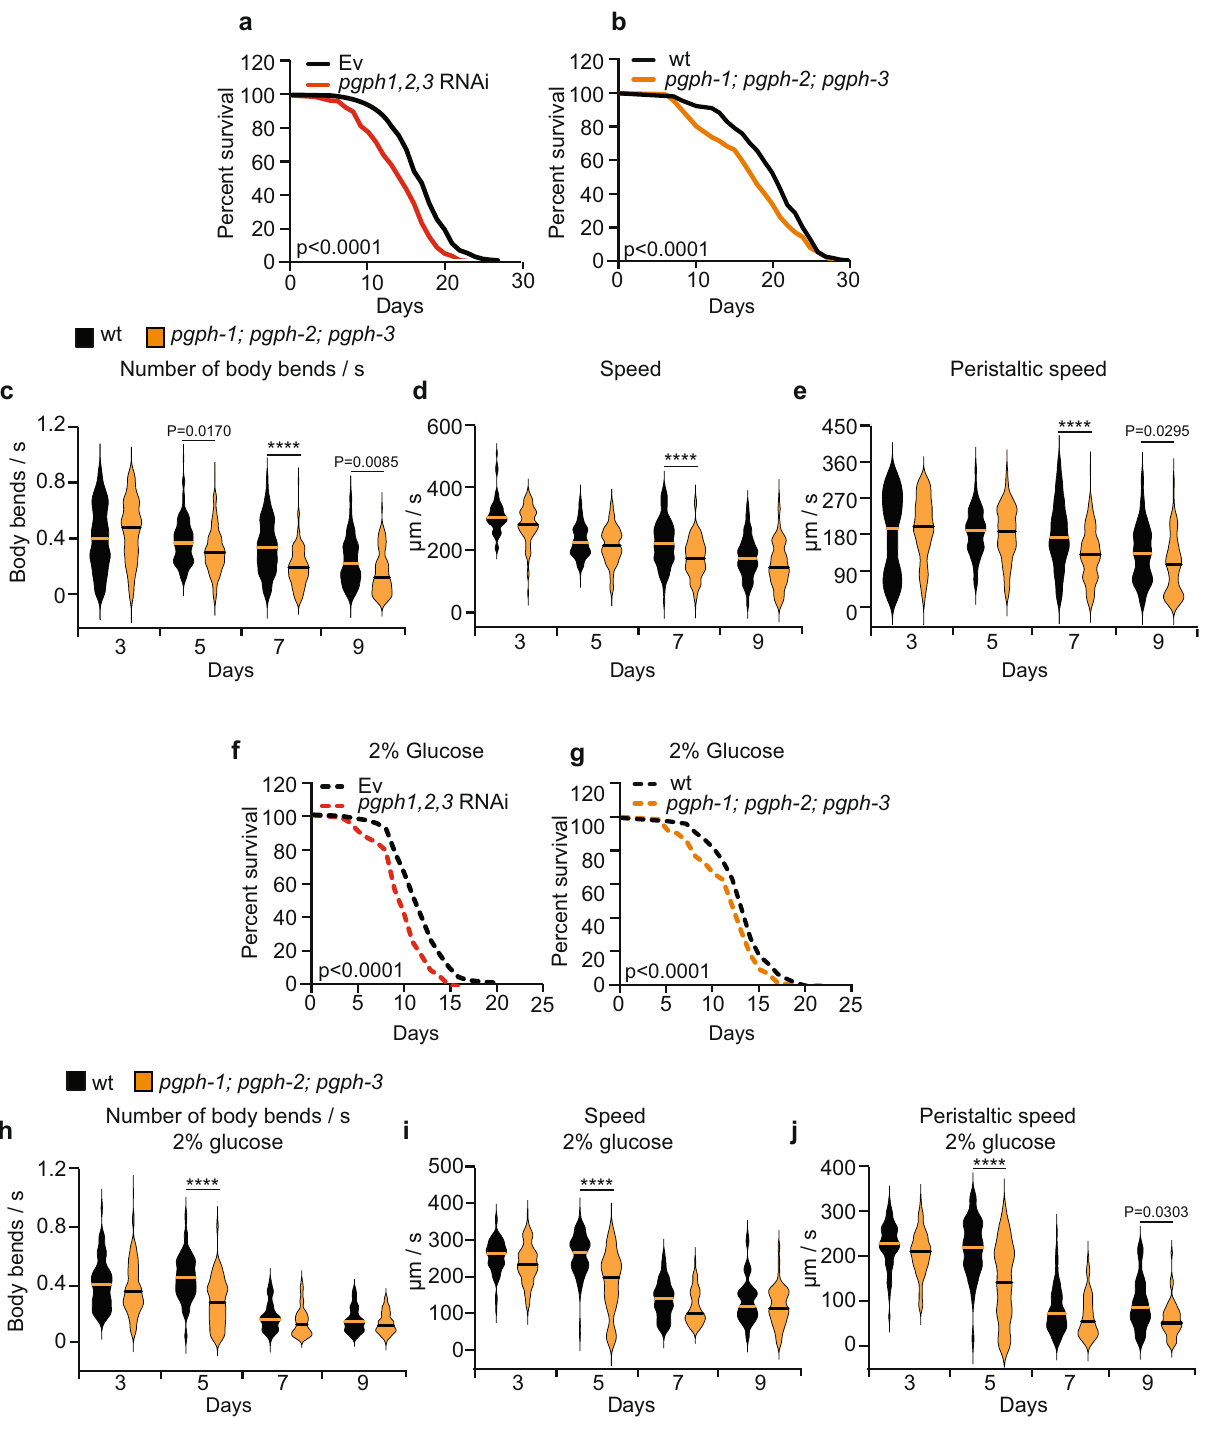
Fig. 5 PGPH loss shortens lifespan and healthspan in normal and high glucose conditions. a Lifespan survival curves of WT animals treated with Ev or pgph RNAi. b Lifespan survival curves of indicated worm strains on NGM plates. c – e Locomotion analysis of worm body bends/s ( c ), speed ( d ), and peristaltic speed ( e ) of indicated worm strains at days 3, 5, 7, and nine of age. Data is represented using violin box plots from three independent experiments with indicated median lines. More than 150 tracks are analyzed per condition and an exact number of tracks is shown in the data source. f , g Survival curves of indicated worm strains grown on plates supplemented with 2% glucose. h – j Locomotion analysis of worm body bends/s ( h ), speed ( i ), and peristaltic speed ( j ) of indicated worm strains grown on plates supplemented with 2% glucose at days 3, 5, 7, and 9 of age. Data is represented using violin box plots from three independent experiments with indicated median lines. More than 150 tracks were analyzed per condition and an exact number of tracks is shown in the data source. Number of separate lifespan and glucotoxicity experiments, animals, and detailed statistics are shown in Supplementary Data 2 and 3. Signi fi cance in all fi gures: **** P < 0.0001. P -values of lifespan and glucotoxicity experiments were obtained by two-sided Mantel – Cox. P -values of locomotion analysis were obtained by one-way ANOVA with the Bonferroni test. Data are provided as a Source Data fi